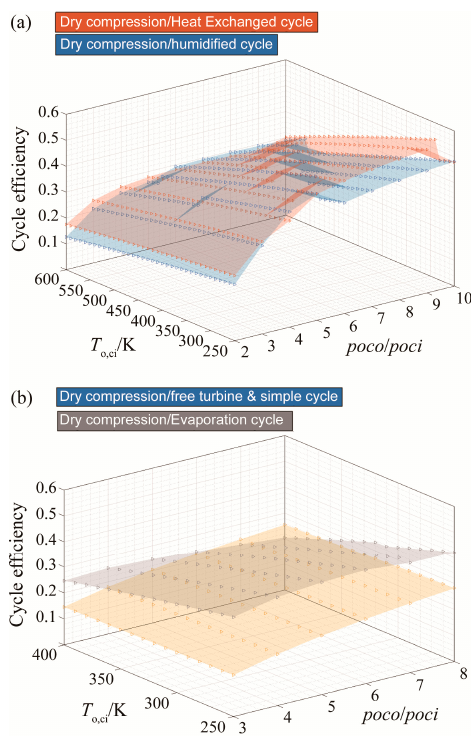
Figure 7. Efficiency results for all cycles with dry compression, for ( a : the heat exchanged and humidified cycles), ( b : the free turbine & simple cycle and the evaporative